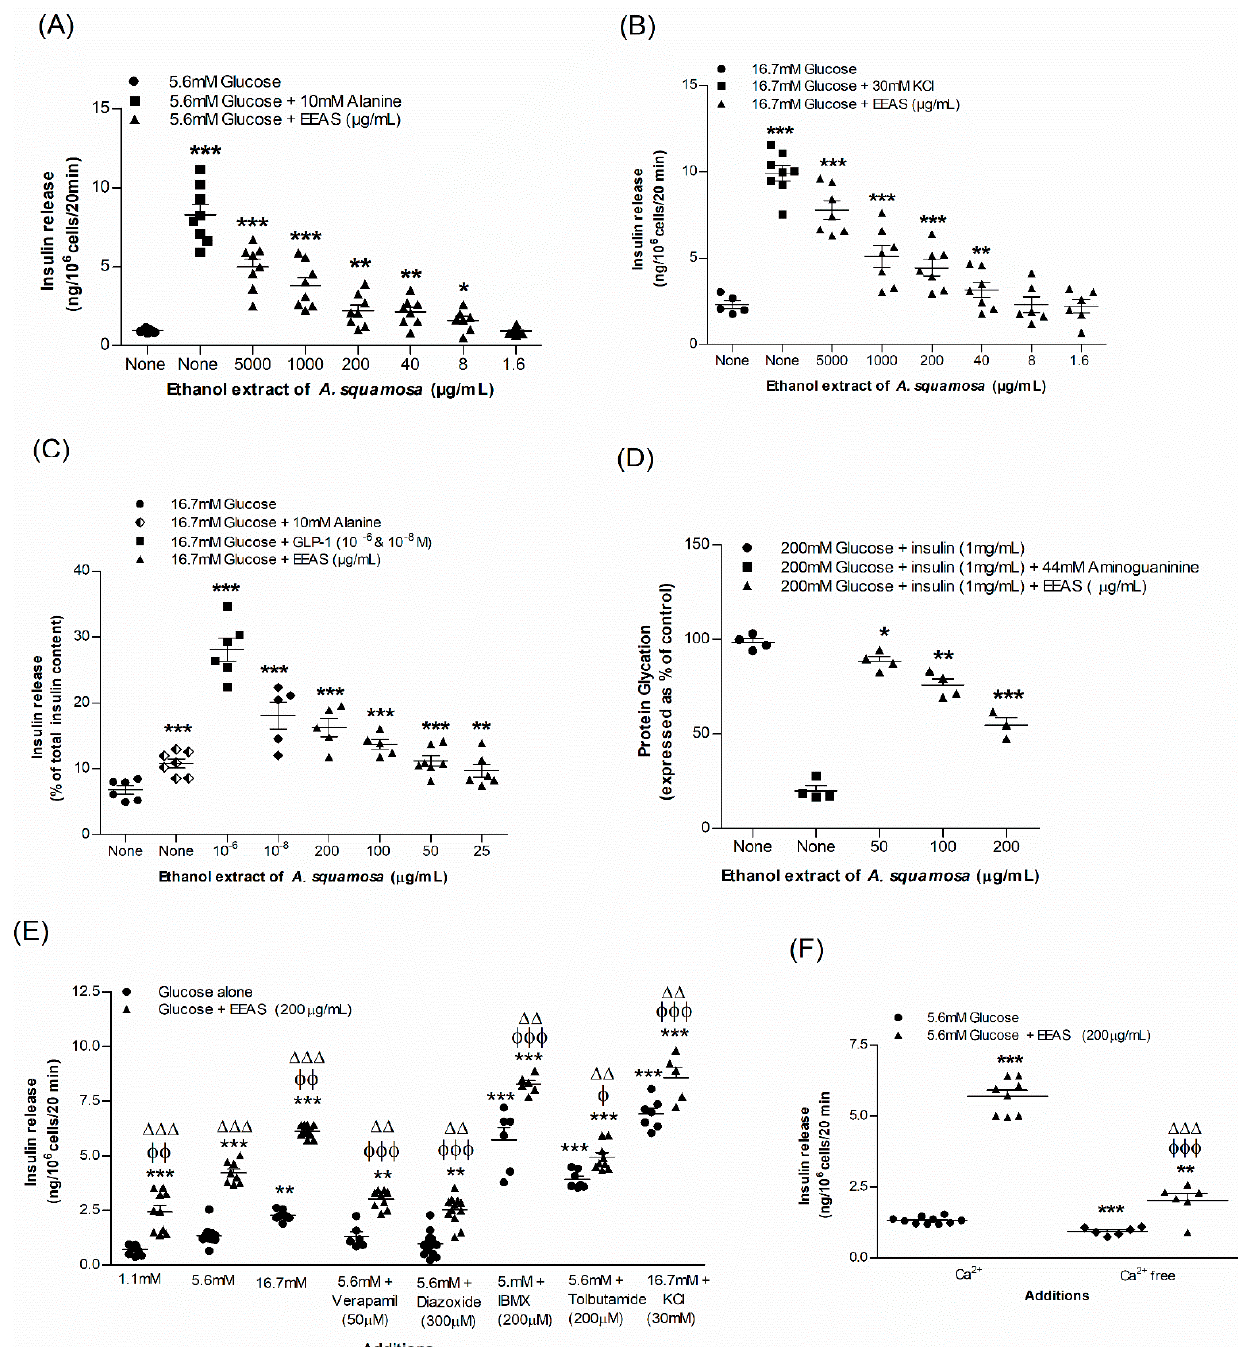
Figure 1. Effects of EEAS on insulin secretion from ( A , B ) clonal pancreatic β -cells (BRIN-BD11) and ( C ) islets of Langerhans, ( D ) glycation of protein, ( E ) secretion of insulin with known stimulators/inhibitors, and ( F ) with/without extracellular calcium from clonal β -cells. Values n = 4–8 for insulin secretion and glycation of protein are mean ± SEM. *, **, *** p < 0.05–0.001 compared to control. ϕ , ϕϕ , ϕϕϕ p < 0.05–0.001 compared to 5.6 mM glucose with EEAS. ΔΔ , ΔΔΔ p < 0.05–0.001 compared to respective incubation without EEAS. EEAS, ethanol extract of A. squamosa.